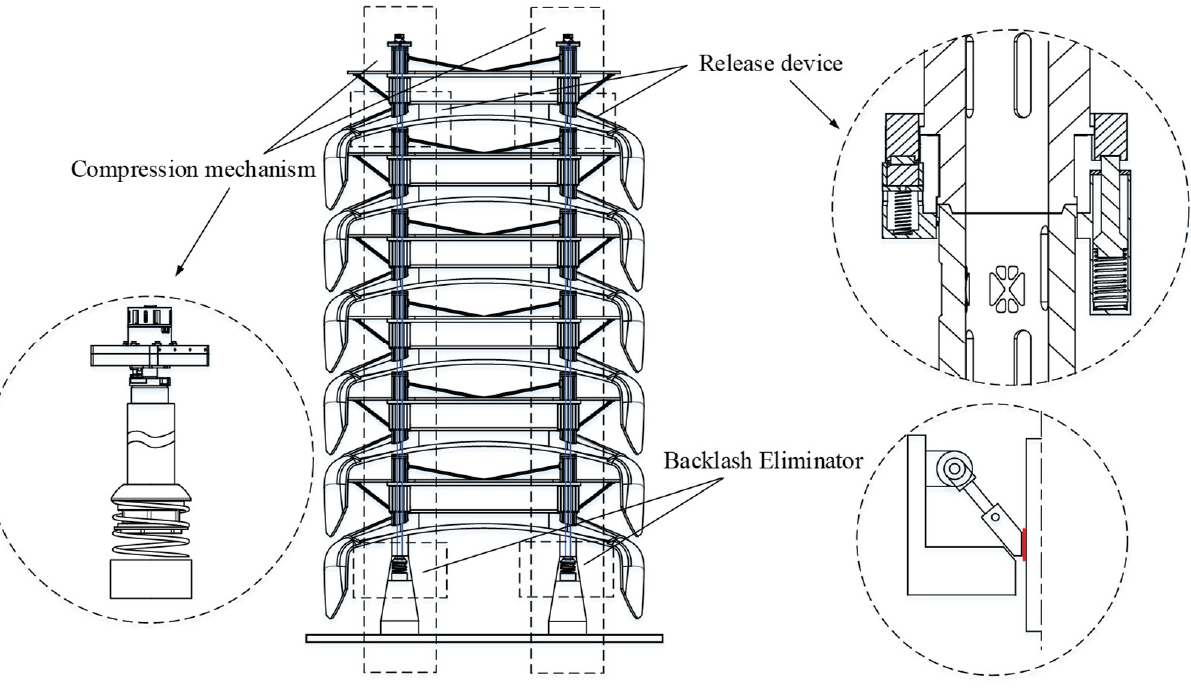
Figure 2. System composition.